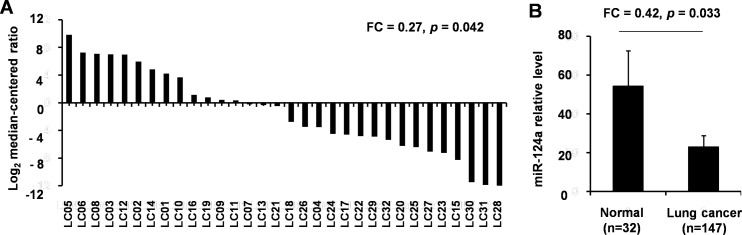
Expression of miR-33a in normal lung and NSCLC tissues.A, The expression levels (log2 median-centered ratio) of miR-33a in 32 paired cancers vs. adjacent non-tumor tissues were analyzed. B, The miR-33a expression in NSCLC samples (n = 147) and paired adjacent non-tumor tissues (n = 32) was analyzed.